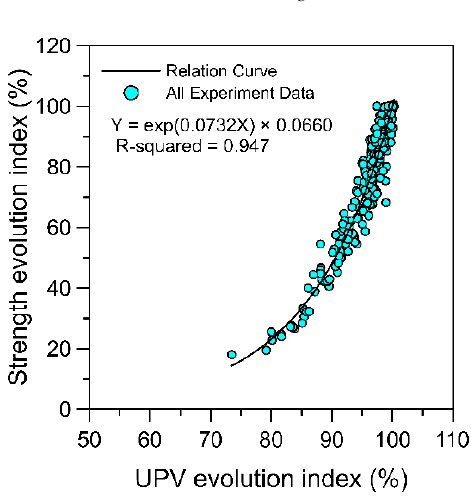
Figure 8. Compilation of the test data of all mixture proportions to establish a general regression relationship curve of the UPV and the strength evolution index.